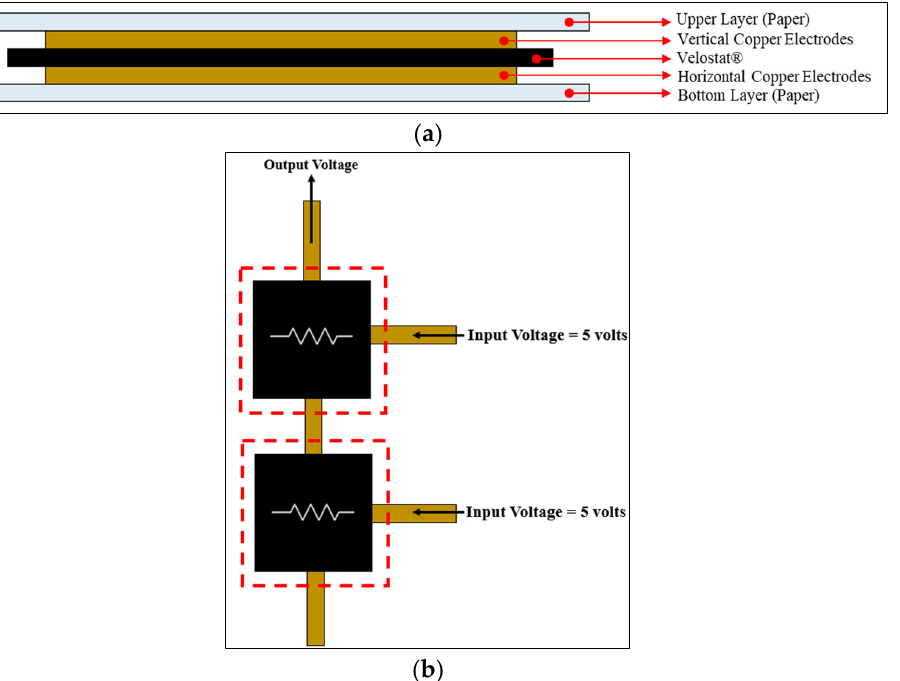
Figure 3. Schematic: ( a ) for the placement of copper electrodes and the pressure sensitive film; ( b ) connection of consecutive sensing points.